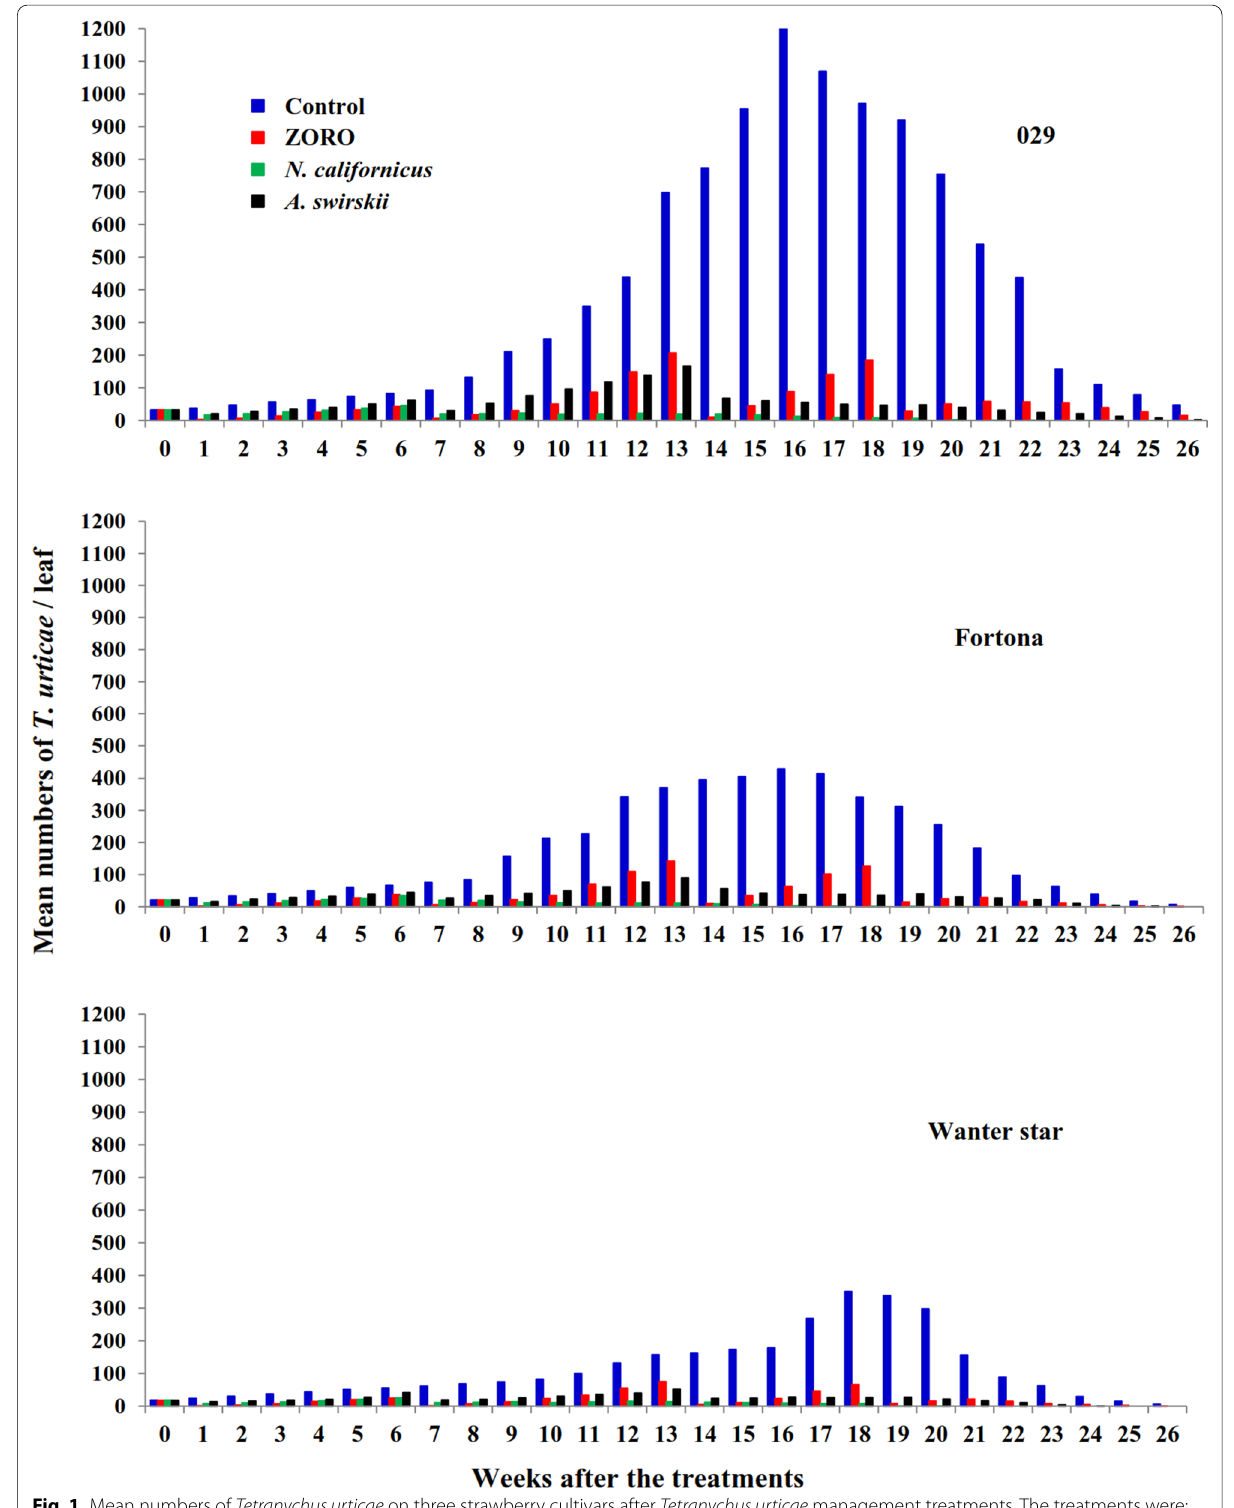
Fig. 1 Mean numbers of Tetranychus urticae on three strawberry cultivars after Tetranychus urticae management treatments. The treatments were: Neoseiulus californicus, Amblyseius swirskii release, ZORO acaricide and untreated